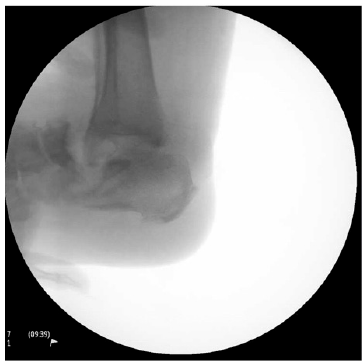
Figure 4. Intraoperative radiograph.